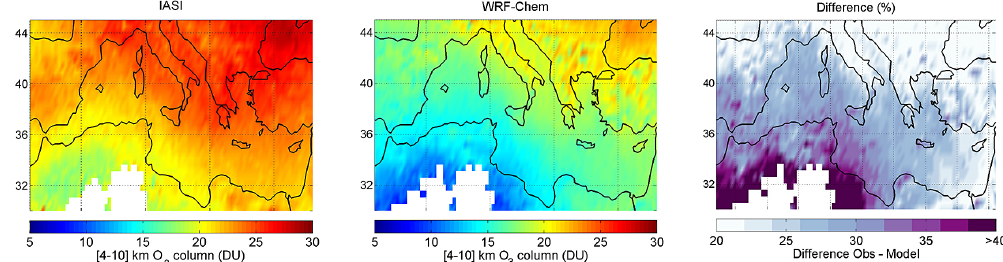
Figure 7. Average [4–10]km O 3 column for JJA 2010 from IASI and WRF-Chem and their relative difference (%). White pixels correspond to a filter applied to poor spectral fits above the Sahara.